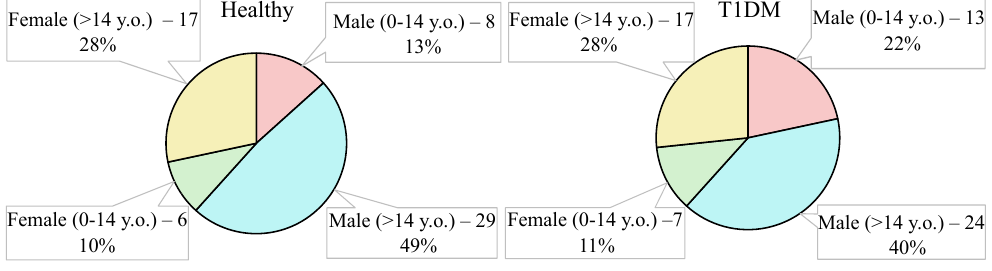
Figure 5. Groups under the